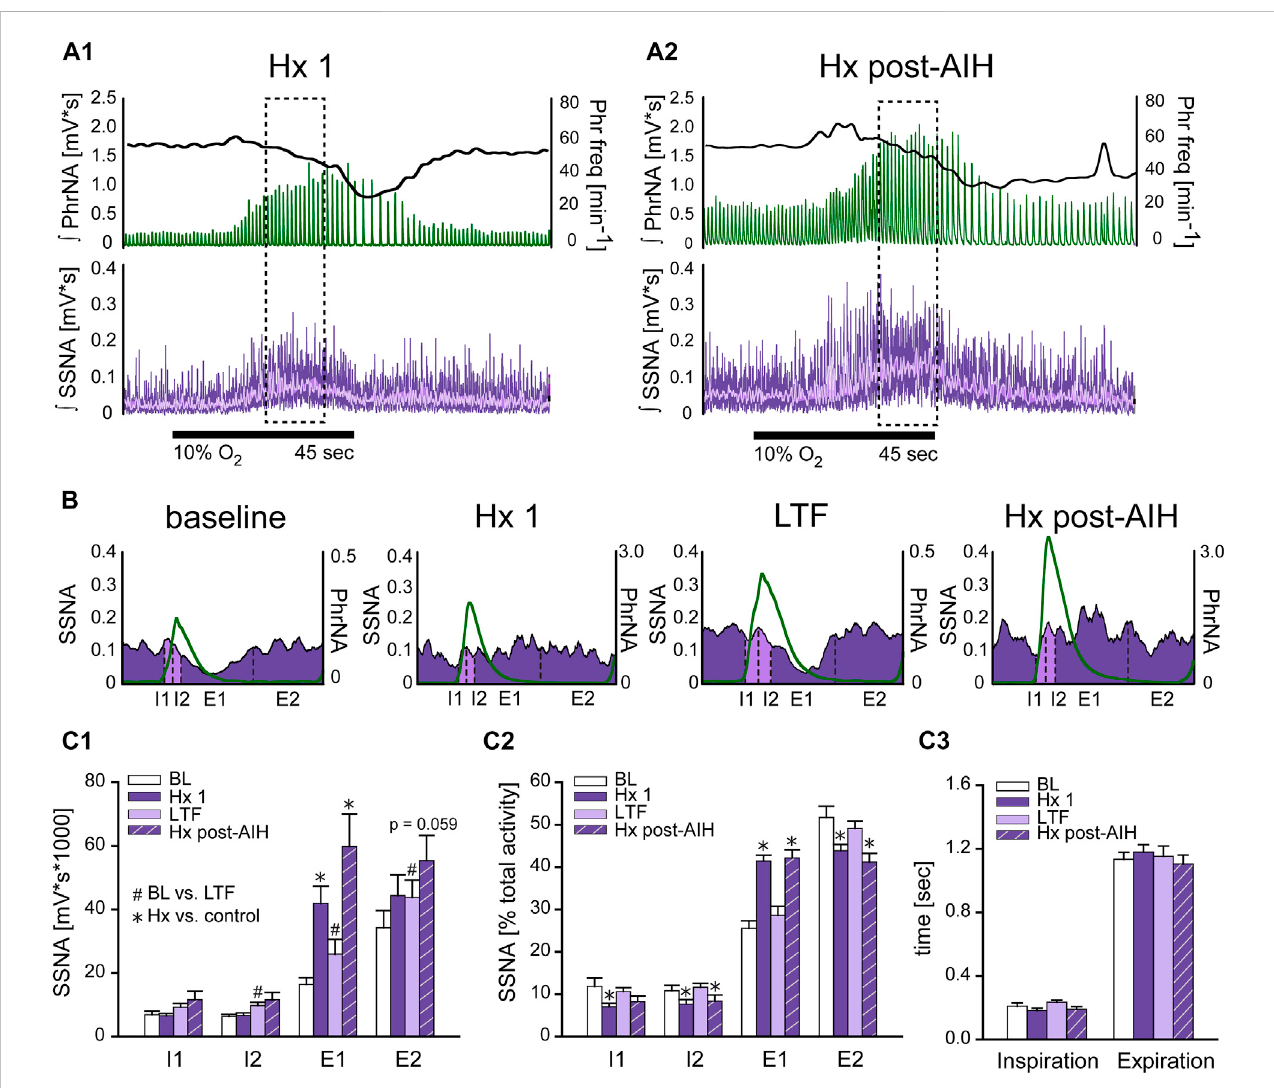
FIGURE 5 Hypoxia but not LTF alters sympathorespiratory coupling. (A) : Example recording of ʃ PhrNA (green), Phr frequency (black, right axis) and ʃ SSNA (purple, mean in light purple) during Hx 1 (A1) and Hx-post-AIH (A2) . Dashed box highlights analysis window for sympathorespiratory coupling during hypoxia, taken during the peak SSNA response; note that this occurred after the initial increase in Phr freq. Horizontal black line indicates period breathing 10% O 2 (45 s). (B) : Phrenic triggered averagesof SSNA from arepresentativeanimalduring baseline breathingO 2 enriched air, Hx1, AIH-induced LTF inO 2 enriched air (1 h after AIH) and during Hx post-AIH. Green trace is average respiratory cycle. SSNA during inspiration (I) is marked in light purple and during expiration (E) in purple.Dottedlinesdividephasesinto fi rstandsecondhalfofinspiration(I1, I2)and fi rstandsecondhalfofexpiration(E1,E2). (C1) :Meanareaunderthecurve of phrenic triggered averages of absolute values of SSNA (n = 12). Most SSNA during pre-AIH (BL, white bars) occurred during expiration (I1 = I2 < E1 < E2; p ≤ 0.05, Two-way repeated measures ANOVA). During hypoxia (Hx 1, purple bars) SSNA increased in E1 and SSNA during E1 was similar to E2 (I1 = I2 < E1 = E2). 1 h after AIH in O 2 enriched air (LTF, light purple bars) SSNA increased in almost all phases (BL vs. LTF: I1: p = 0.16, I2: p = 0.004, E1: p = 0.0006, E2: p = 0.034. One-way repeated measures ANOVA). (C2) : Normalized SSNA (% total activity within a given cycle). Hypoxia increased the relative amount of SSNA in E1 but decreased relative SSNA in I1, I2 and E2. No differences in the pattern of PhrNA and SSNA coupling were observed after AIH in O 2 (BL vs. LTF: p = 0.89) or hypoxia (Hx 1 vs. Hx post-AIH: p = 0.967. (C3) : Mean time of I and E. Total time of inspiration and expiration was not signi fi cantly altered by LTF or during